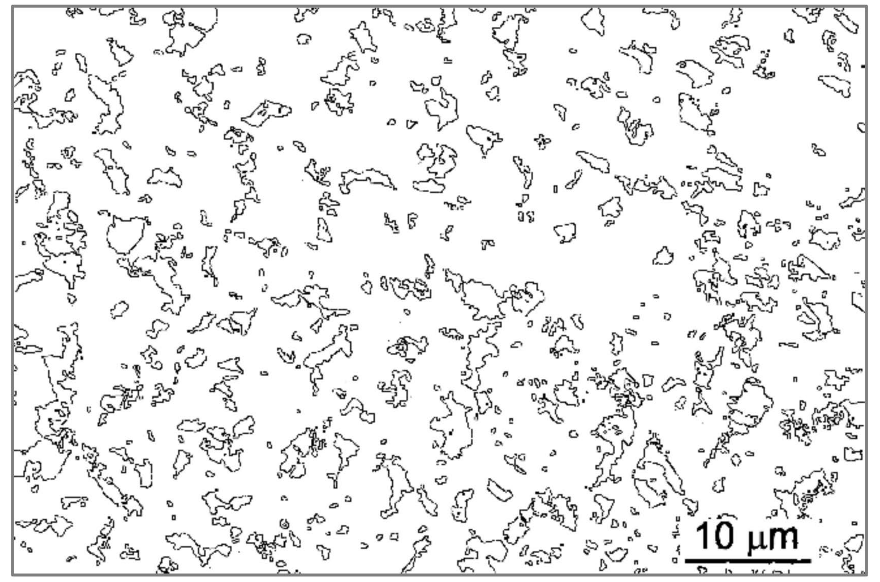
Figure 11. Typical binary image with